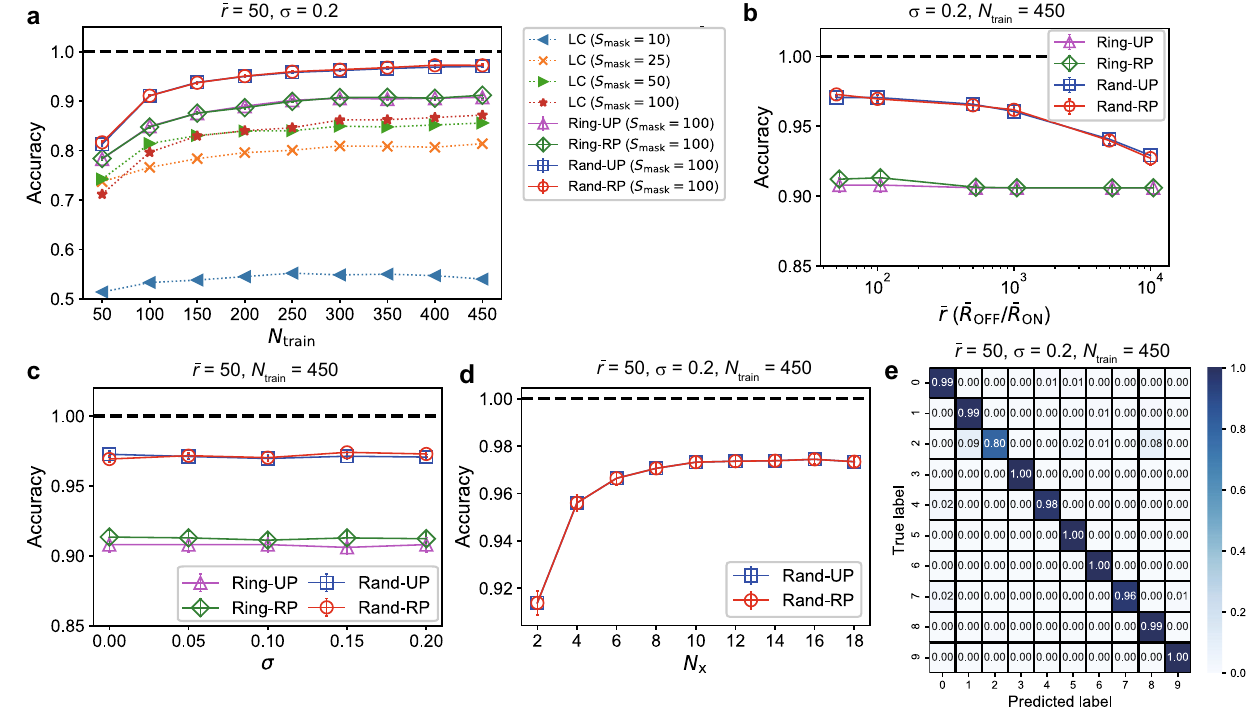
Figure 7. Results of the spoken digit recognition task. ( a ) The classification accuracies when the number of training data N train is varied. The results with the linear classifier (LC) include the four cases with S mask = 10, 25, 50, 100 . The results with the memristive RC systems include the four cases with Ring-UP, Ring-RP, Rand-UP, and Rand-RP, where S mask = 100 . ( b ) The classification accuracies plotted against the average ON/OFF ratio ¯ r . ( c ) The classification accuracies plotted against the variability parameter σ . ( d ) The classification accuracies when N x signals out of N m ( = 20 ) current signals were used for the readout. ( e ) The confusion matrix for testing data.